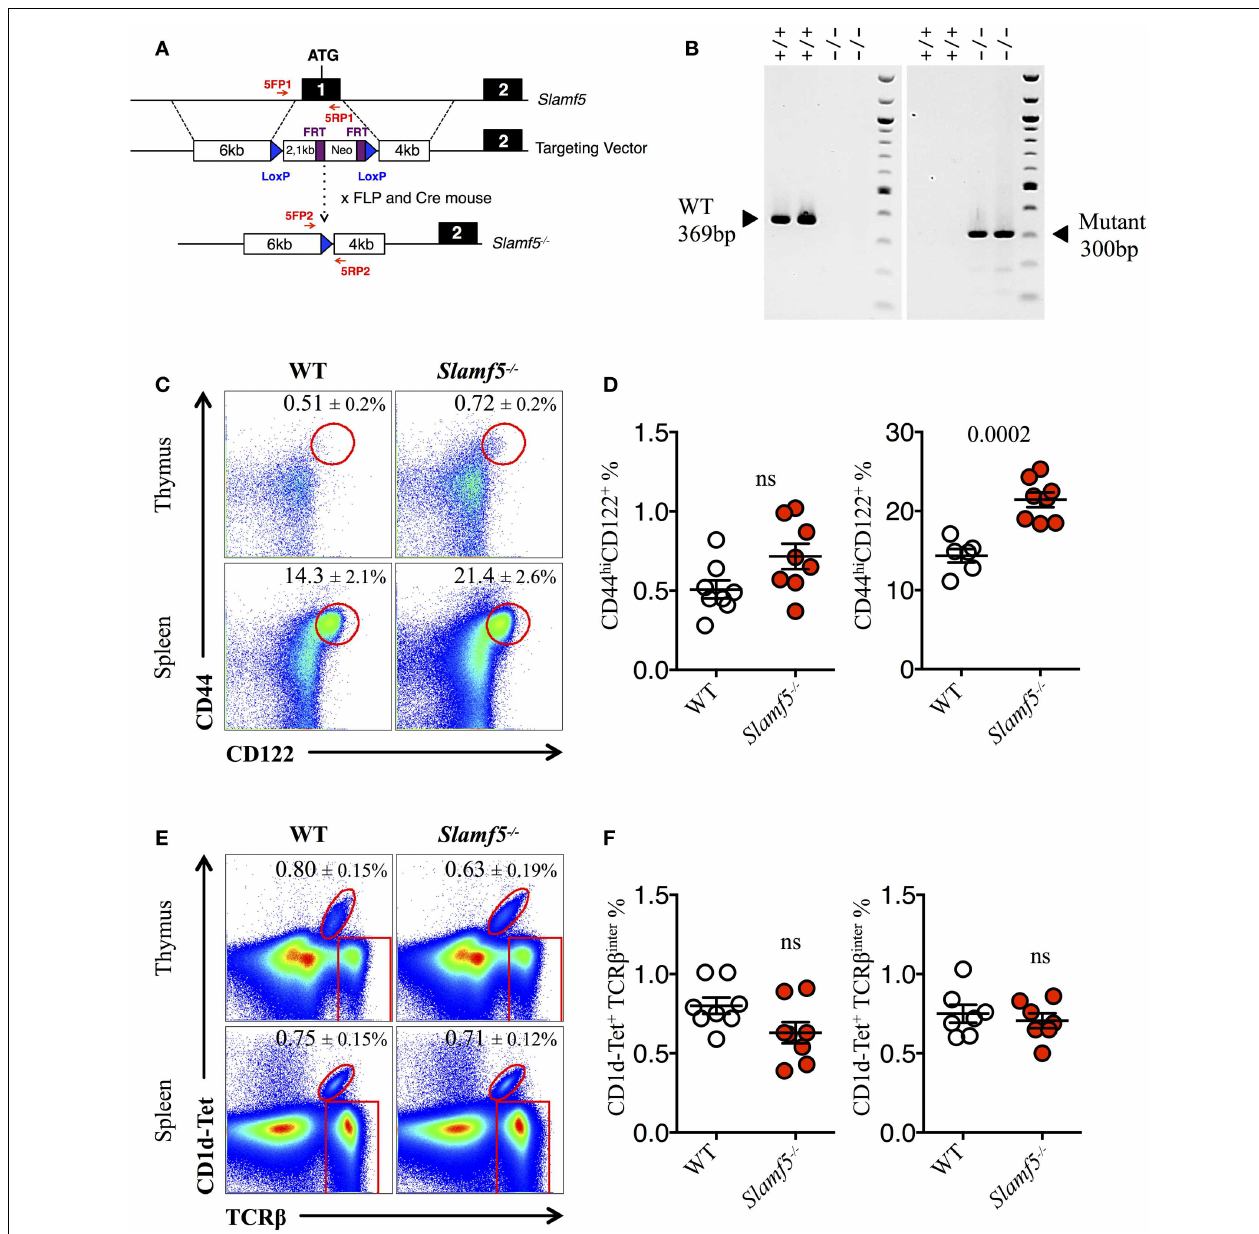
lymphocytesTCR β hi CD8SP ( thymus ) orTCR β + CD8SP ( spleen ). (D) Percentage of CD44 hi CD122 + CD8SPT cells in thymus ( left ) or spleen ( right ) ofWT or Slamf5 − / − B6 mice. (E) Representative FACS plots showing PBS-57 CD1d-tetramer (CD1d-Tet) reactive NKT cells from thymus or spleen ofWT or Slamf5 − / − B6 mice. FACS plots are gated on live singlets lymphocytes. (F) Percentage of CD1d-Tet + TCR β inter cells in thymus ( left ) or spleen ( right ) ofWT or Slamf5 − / − mice. Numbers inside plots show the mean percentage ± SD of innate-like CD8 + T cells (C) , or NKT cells (E) . Red rectangles in (E) depict the lymphocyte gate in which innate CD8 + T cells were analyzed. Cumulative graphs show the results of three independent experiments, mean ± SEM.The p values were calculated by unpaired t -test between theWT group and the Slamf5 − / − group. A value of p < 0.05 was considered significant; ns,